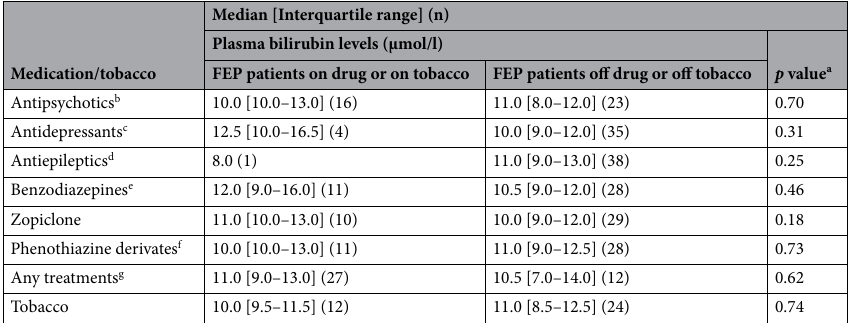
Table 2. Plasma bilirubin with regard to medication and tobacco use in individuals with FEP. Abbreviations: FEP, First-episode psychosis; (n), number. a Mann-Whitney U-test, two-sided. b All antipsychotics combined. c All antidepressants combined. d All antiepileptic’s combined. e All benzodiazepines combined. f All Phenothiazine derivatives combined. g Either N, AD, AE, BZD, Z, PD or a combination of these drugs.